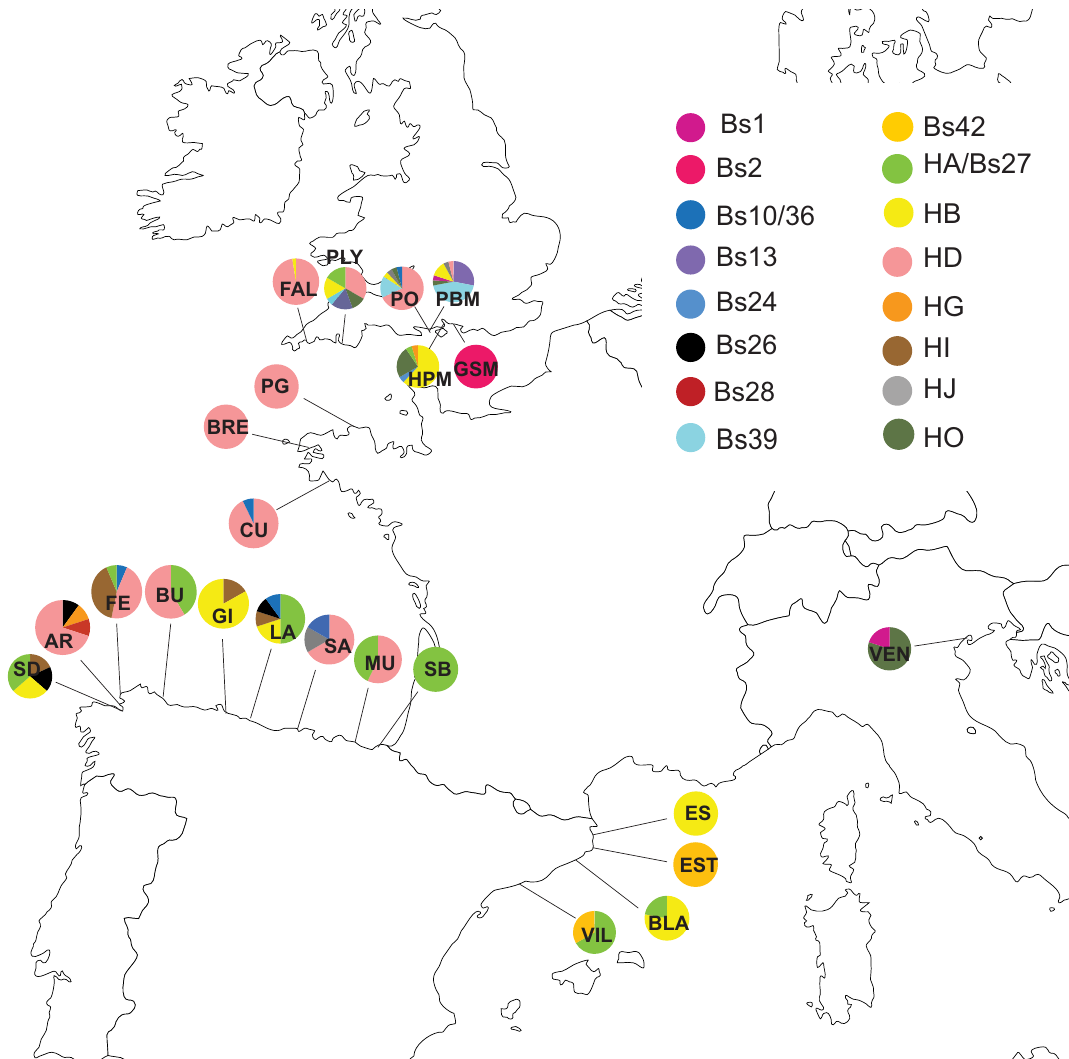
Fig 2. Clade A haplotype frequencies in the northeastern Atlantic populations sampled by the authors of this study. The population abbreviationsare as follows: AR = Ares, Spain; BLA = Blanes, Spain; BRE = Brest, France; BU = Burela, Spain; CU = Concarneau, France; ES = L’Escala,Spain; EST = Estartit, Spain; FAL = Falmouth, England;FE = Ferrol, Spain; GI = Gijon, Spain; GSM = Gosport, England;HPM: Hamble, England;LA = Llastres, Spain; MU = Mutriku, Spain; PBM = ParkstoneBay, England;PG = Perros-Guirec, France; PLY = Plymouth, England;PO = Poole, England, SA = Santander; SB = San Sebastian, Spain; SD = Sada, Spain; VEN = Venice, Italy; VIL =